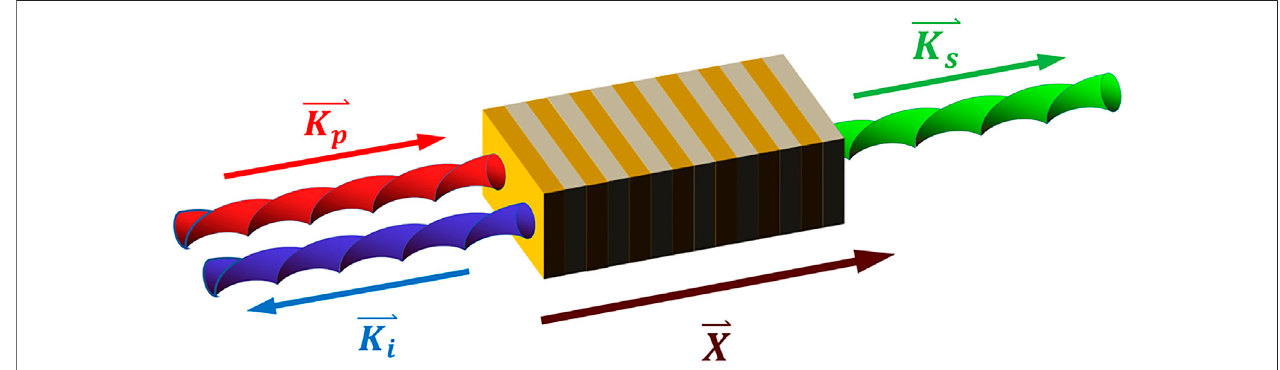
FIGURE 1 | Schematic of the backward OPO pumped by vortex